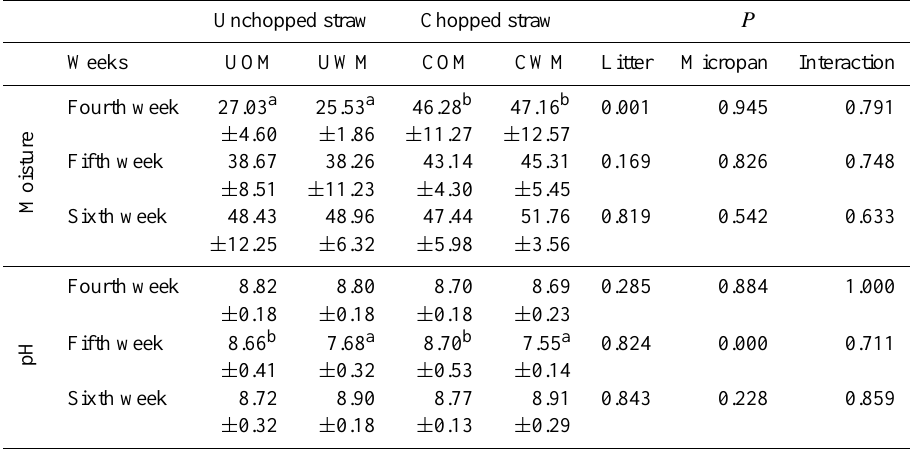
Table 1. Moisture content (%) and pH of litter (unchopped or chopped straw) with or without addition of Micropanin in the fourth, fifth, and sixth week of age ( ¯ x ± SD).